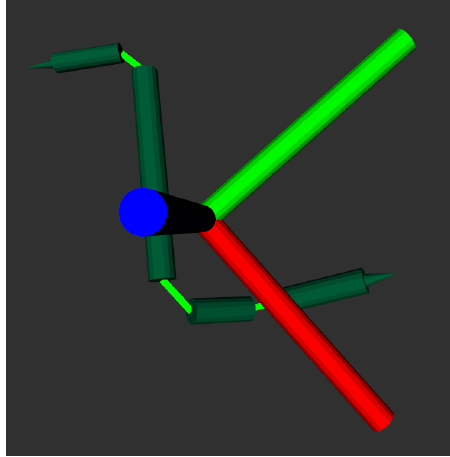
Figure 7. Example of the coordinate frame for a tube’s orientation.